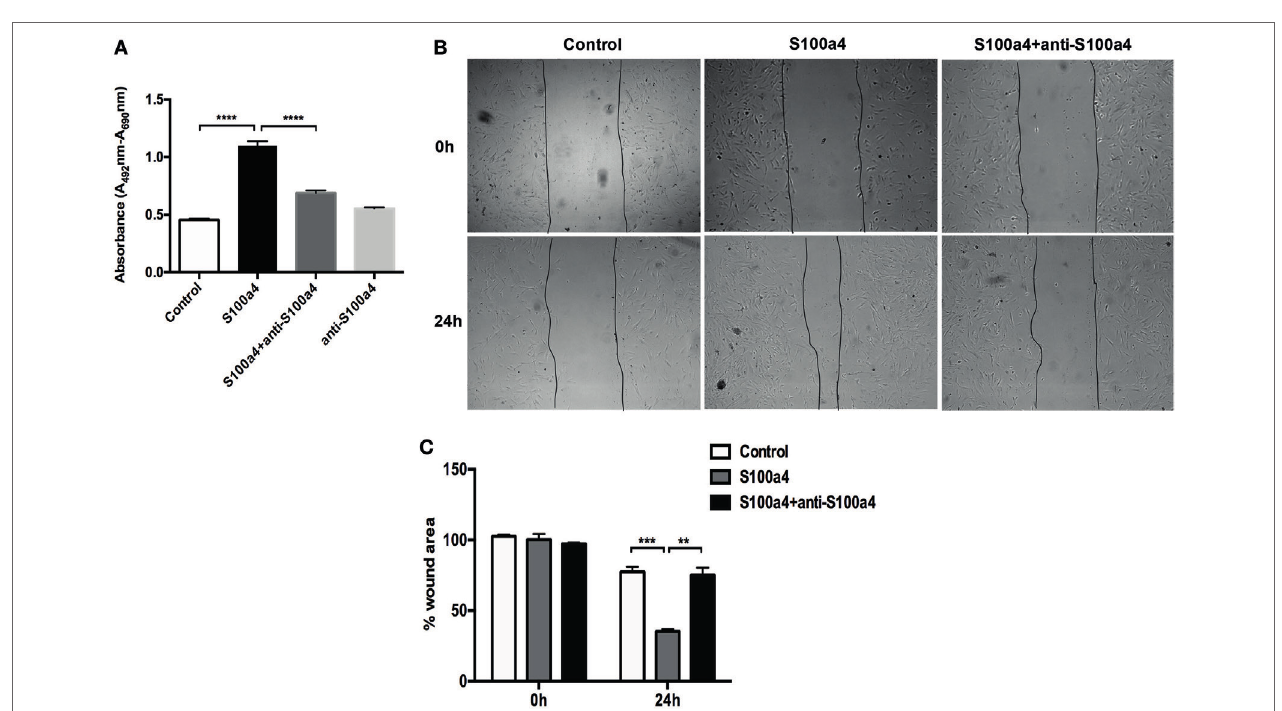
FigUre 5 | S100a4 accelerates lung fibroblast proliferation and migration. (a) Primary lung fibroblasts were treated with 2 µg/ml recombinant S100a4 or with recombinant S100a4 in the presence of a S100a4 neutralizing antibody or with antibody alone for 72 h. Cell proliferation was analyzed using the XTT kit. Results are representative of three independent experiments with similar results. Shown are mean ± SD of five replicates from one experiment. Unpaired t-test was performed for statistical analysis (**** denotes p < 0.0001). (B) Direct migration of primary lung fibroblasts in the presence of 2 µg/ml recombinant S100a4 or recombinant S100a4 in the presence of the S100a4 neutralizing antibody was analyzed by wound healing assay. Wound closure was determined 24 h after scratching. Representative phase-contrast pictures of the cells at 0 (immediately after the scratch) and 24 h after the scratch are shown. The assay was performed three times: one representative experiment is presented. (c) For quantification, the wound area was measured using ImageJ and normalized to control at 0 h. Results are representative of three independent experiments with similar results. Shown are mean ± SD of triplicate samples from one experiment. The effect of stimulation by S100a4 was statistically significant in comparison to the control sample, as evaluated by the unpaired t -test (** denotes p < 0.01; *** denotes p <